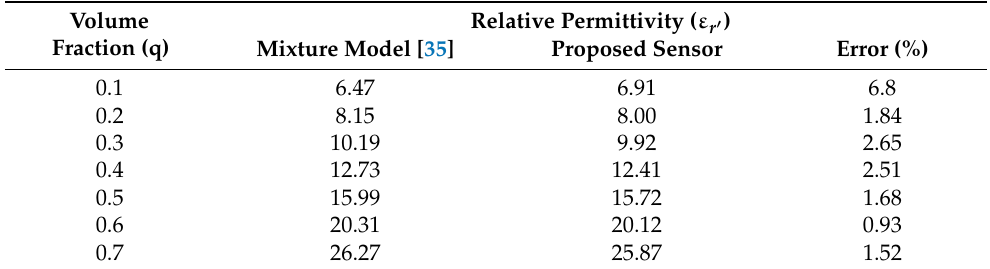
Table 1. Comparison of measured results with theoretical data for ethanol–water solution and